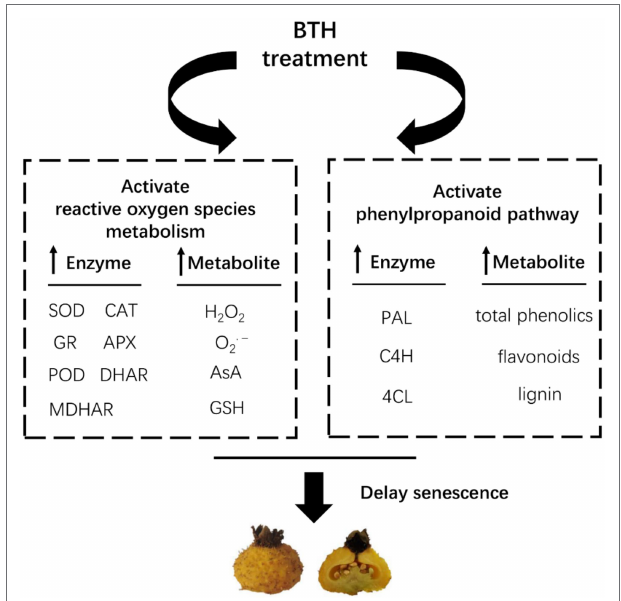
FIGURE 6 | A speculation to explain the role of BTH in regulating fruit senescence in R. roxburghii . Arrow up indicates